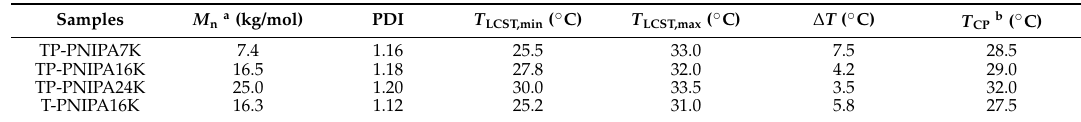
Table 2. Some properties of TP-PNIPAs and T-PNIPA16K.